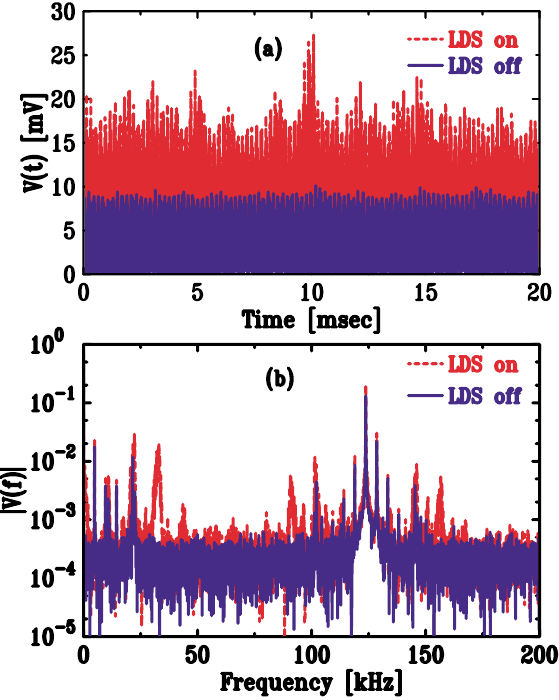
FIG. 9. (Color) (a) Amplified A peak signal for I (cid:6) 46 mA with LDS on and off and (b) the frequency spectrum for these measurements.